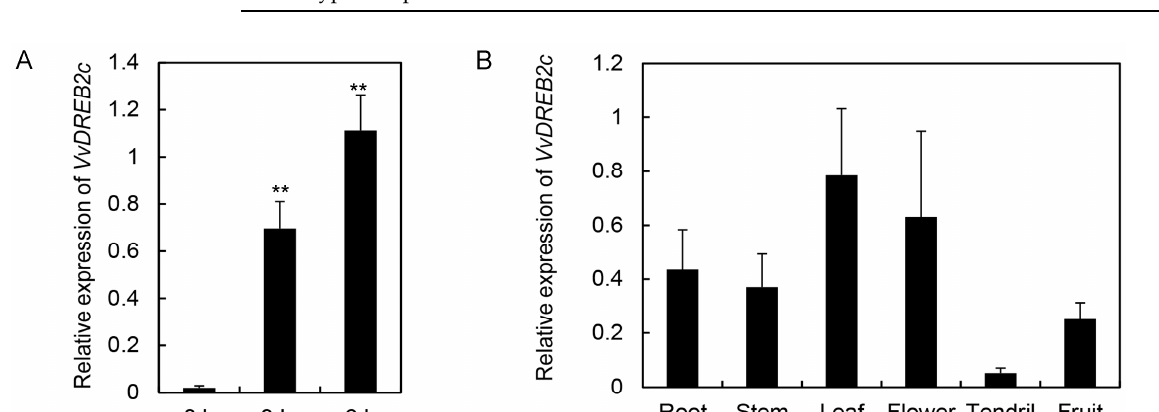
Figure 1. Expression of VvDREB2c in grapevine. ( A ) VvDREB2c expression in grape leaves after 3 and 6 h of high temperature (45 ◦ C) exposure. ( B ) VvDREB2c expression in grapevine organs after 3 and 6 h of high temperature (45 °C) exposure. ** indicates a signi fi cant di ff erence ( p < 0.05). Table 1. Distribution of promoter elements in the promoter region of VvDREB2c in grape.